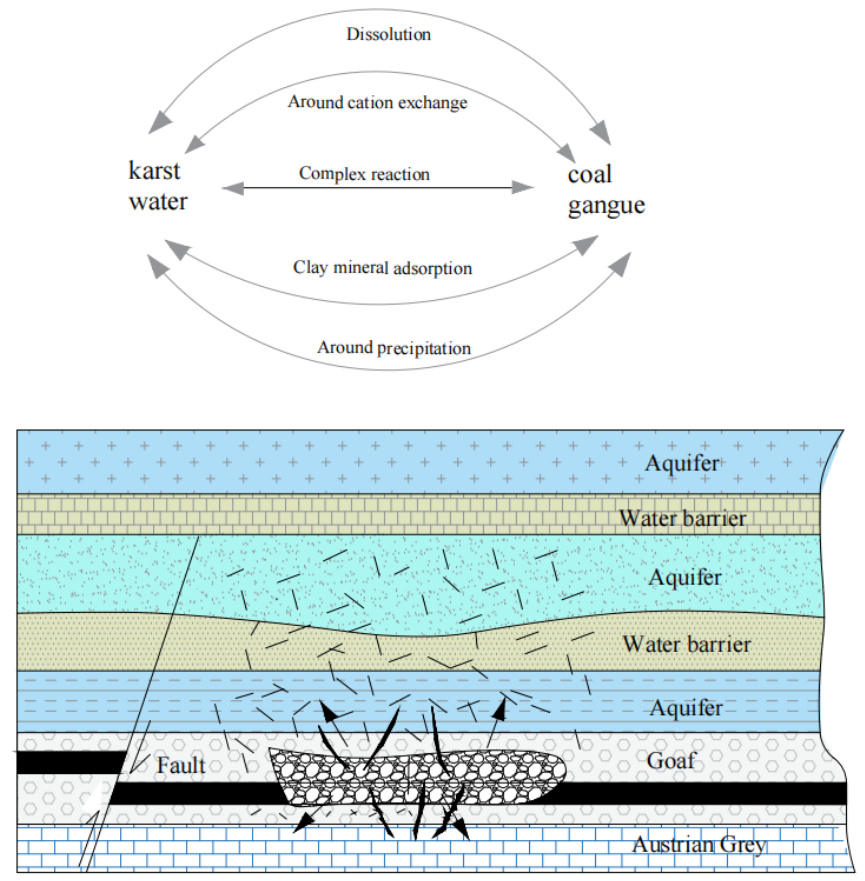
Figure 1. Schematic diagram of water-rock interactions in the mining area.